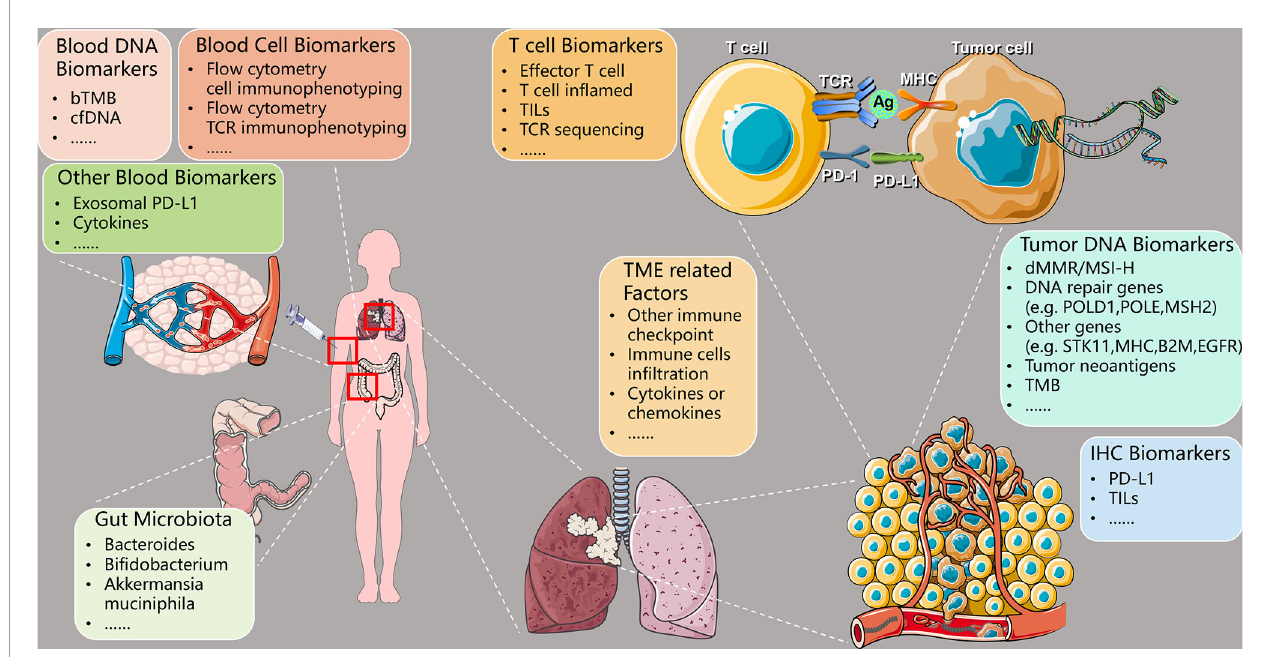
FIGURE 2 | Predictive biomarkers of therapeutic ef fi cacy using PD-1/PD-L1 ICIs in NSCLC. PD-1, programmed cell death-1; PD-L1, programmed death-ligand 1; ICIs, immune checkpoint inhibitors; NSCLC, non-small cell lung cancer; TCR, T cell receptor; Ag, antigen; MHC, major histocompatibility complex; bTMB, blood- based tumor mutational burden; cfDNA, circulating-free DNA; TILs, tumor-in fi ltrating lymphocytes; TME, tumor microenvironment; dMMR, de fi cient mismatch repair; MSI-H, microsatellite instability-high; POLD1 , DNA polymerase delta 1, catalytic subunit; POLE , DNA polymerase epsilon, catalytic subunit; MSH2 , mutS homolog 2; STK11 , serine/threonine kinase 11; B2M , beta-2-microglobulin; EGFR , epidermal growth factor receptor; TMB, tumor mutational burden; IHC,